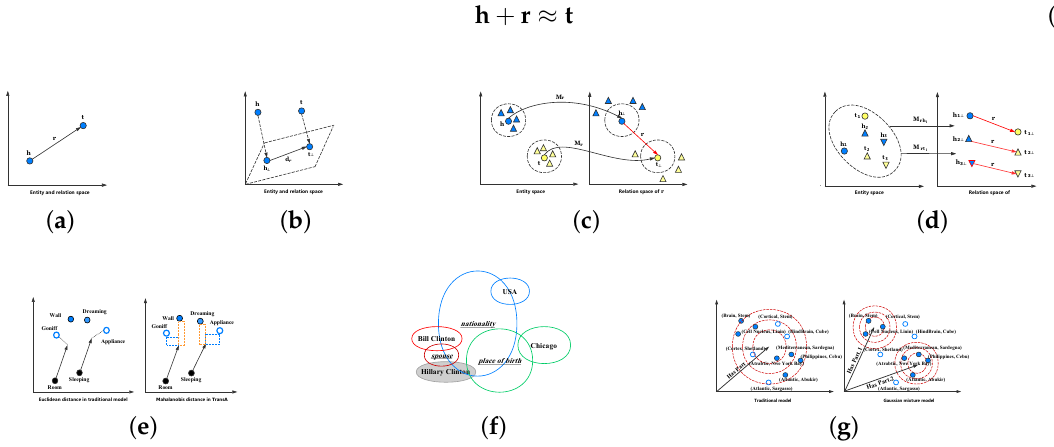
Figure 2. Illustrations of translation-based models. ( a ) TransE, ( b ) TransH, ( c ) TransR, ( d ) TransD, ( e ) TransA, ( f ) KG2E, ( g )